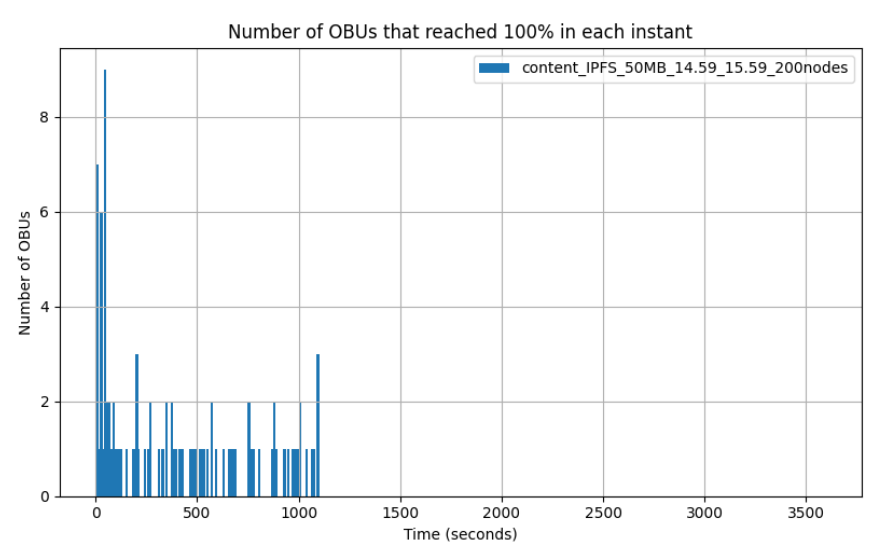
Figure 12. OBUs that downloaded 100% of a 50 MB file distributed across 200 nodes from 15 h to 16 h in EmuCD running IPFS.